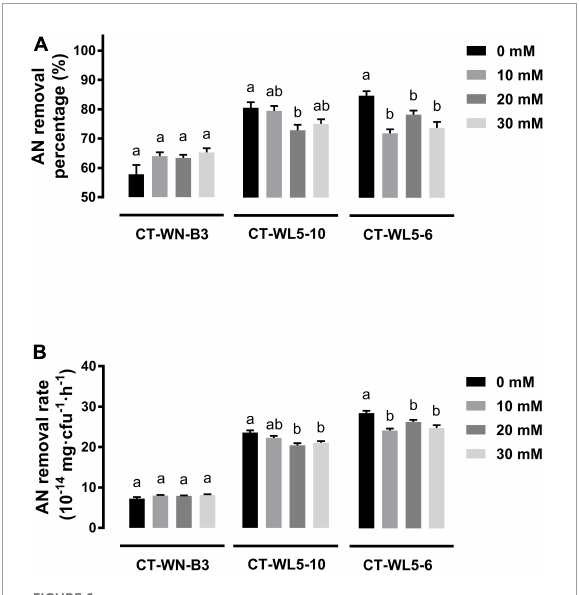
FIGURE6 Alkalinity effect on AN removal. The AN removal percentage (A) and AN removal rate (AN quantity per cell per hour) (B) of strains after 24 h incubation in media with different alkalinities were shown. Values in each strain group with different superscripts in (A,B) were significantly different ( P < 0.05). Columns in different colors represent different NaHCO 3 concentrations.